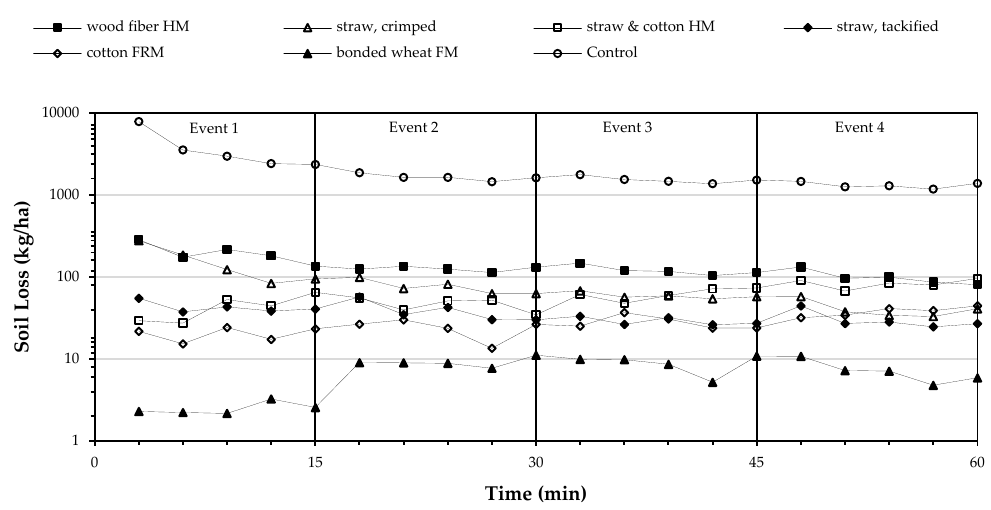
Figure 6. Three-minute soil loss vs. time for all treatments as compared to the control.